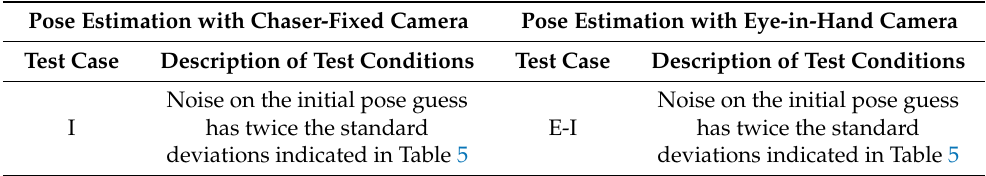
Table 8. Summary of test cases with variable accuracy on the initialization of the pose solution for both the pose estimation with the chaser-fixed and the eye-in-hand